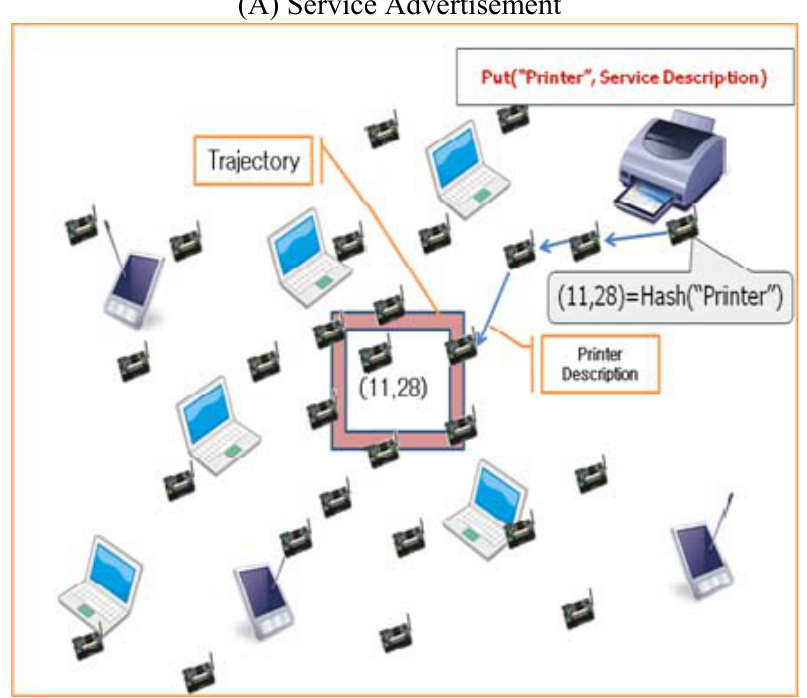
Figure 3. Example of ASST. (A) Service